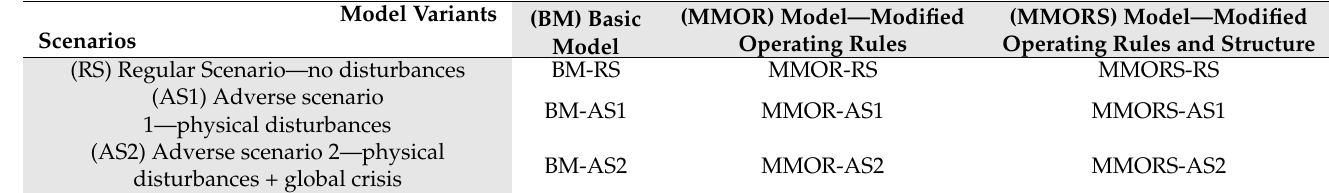
Table 2. Combination of examined scenarios and model